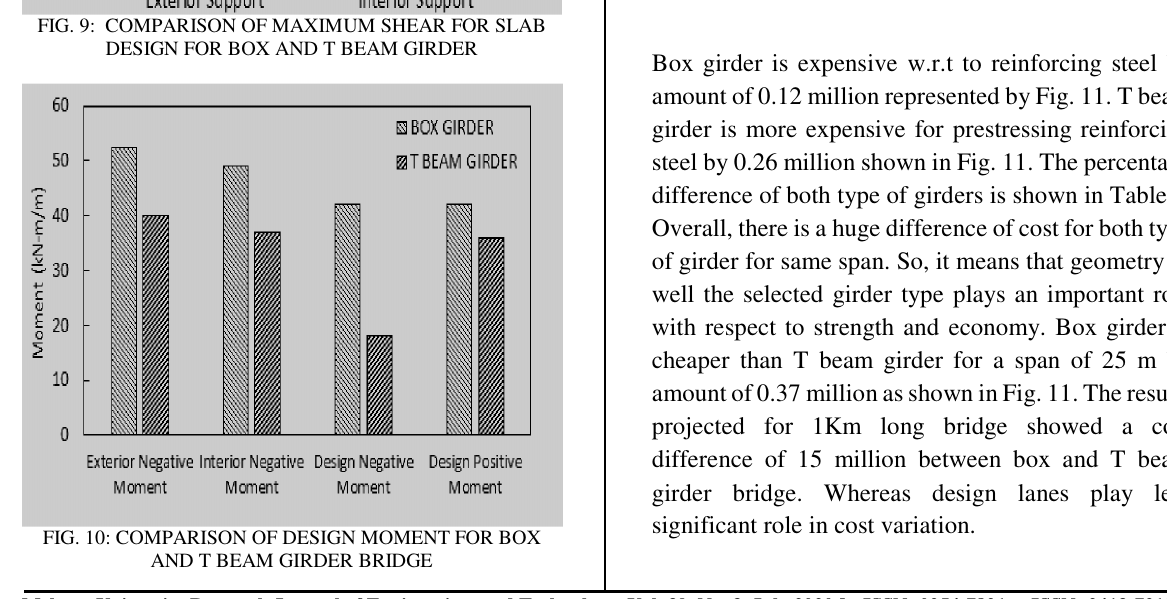
FIG. 10: COMPARISON OF DESIGN MOMENT FOR BOX AND T BEAM GIRDER BRIDGE